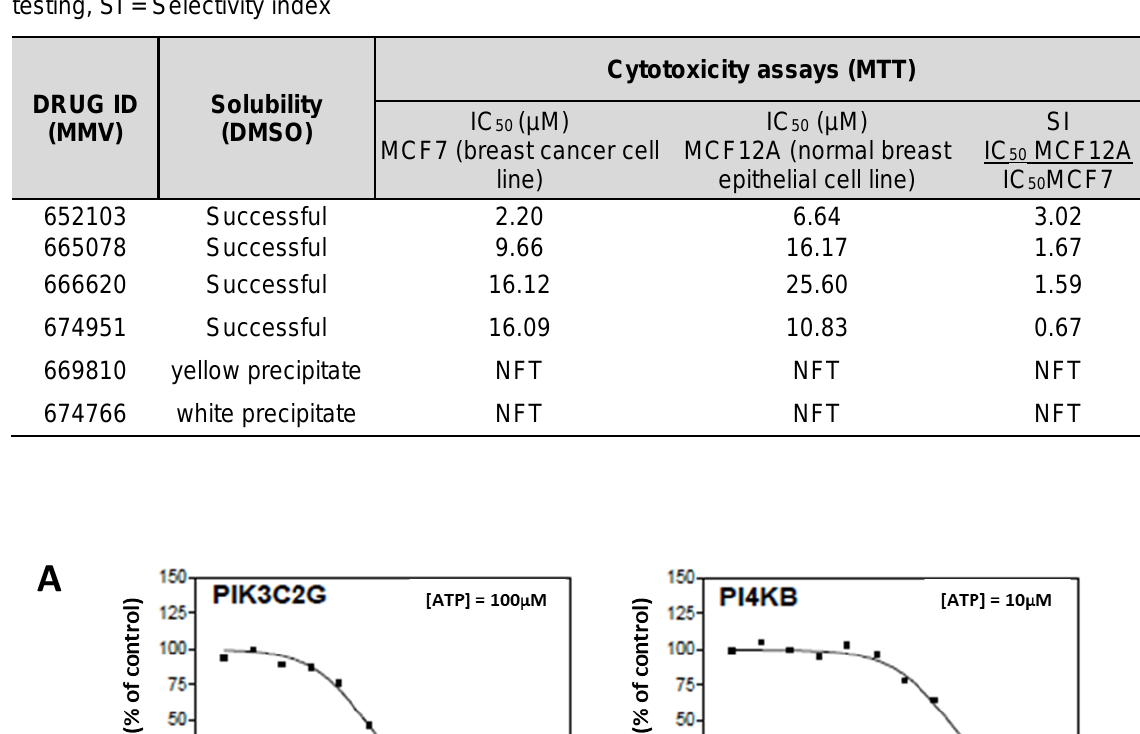
Table 1: Solubility, cytotoxicity, and selectivity of MMV compounds in MCF7 breast cancer and non- malignant MCF12A breast epithelial cell lines were determined using the MTT cell viability assay. The data shown are from three independent experiments each performed in quadruplicate. NFT = no further